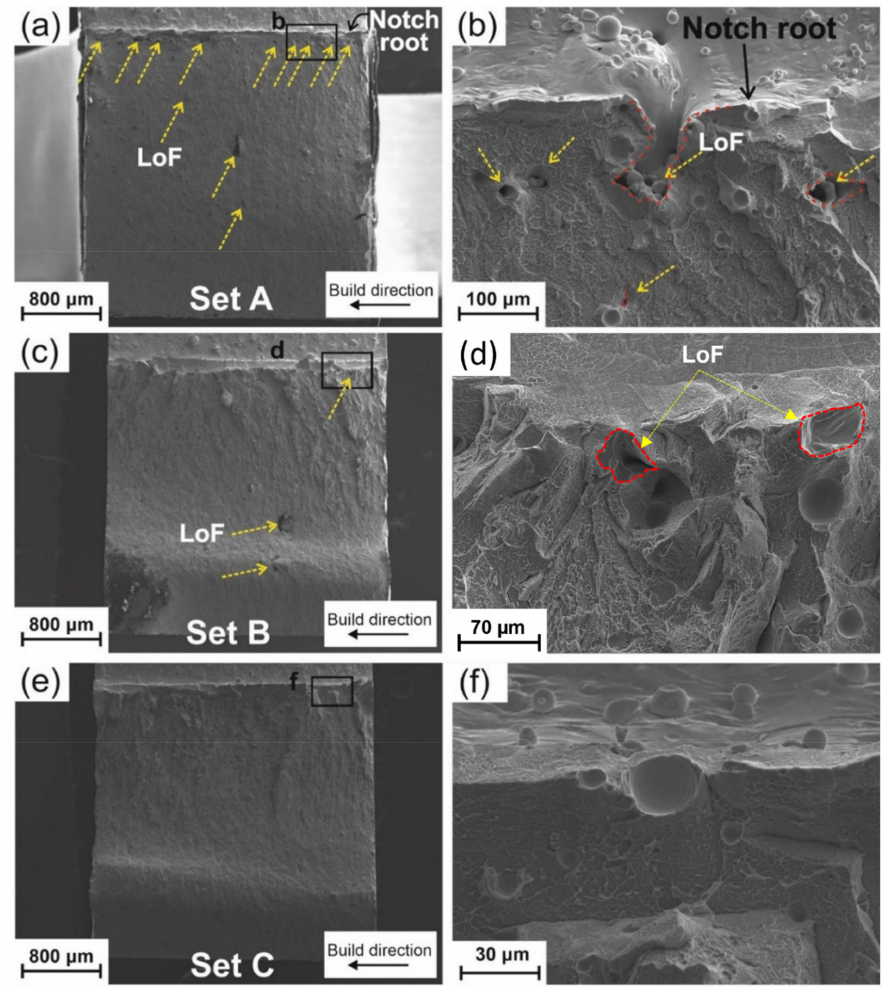
Figure 3. ( a ) Fracture surface of a Set A impact specimen, ( b ) higher magnification image of region b in ( a ), ( c ) fracture surface of a Set B impact specimen, ( d ) higher magnification image of region d in ( c ), ( e ) fracture surface of a Set C impact specimen, and ( f ) higher magnification image of region f in ( e ), shear bands were formed inside the large